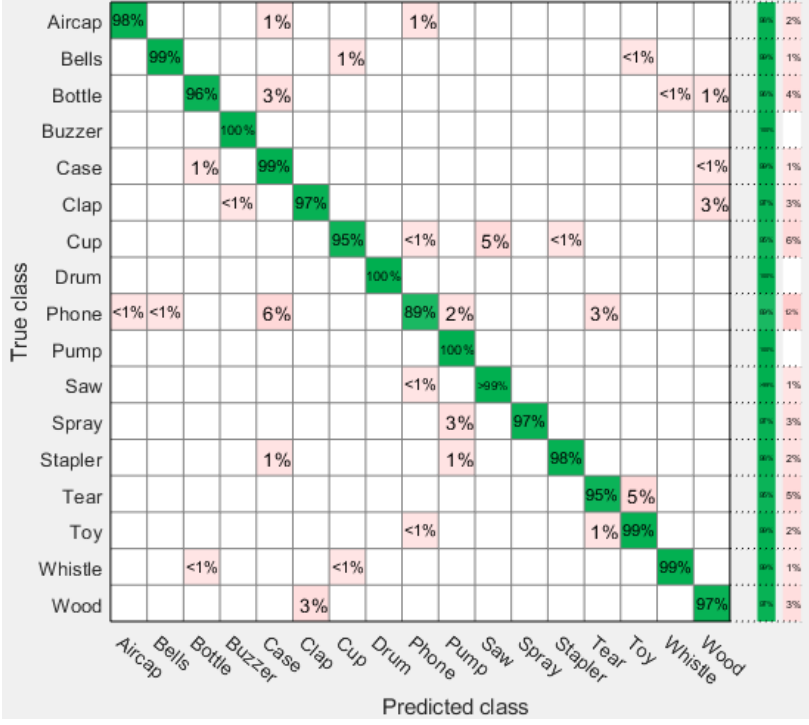
Figure 8. Confusion matrix of the proposed approach for RWCP Figure 6: Confusion matrix evaluation on RWCP